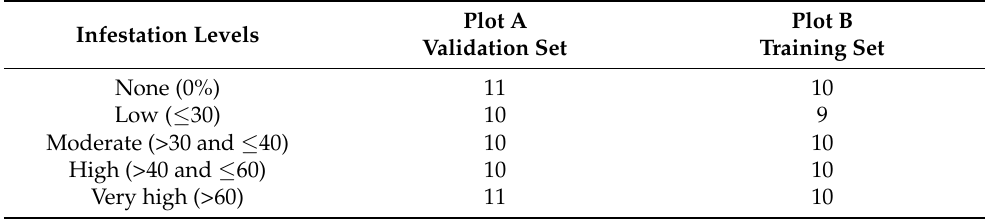
Table 3. Description of the datasets distinguishing by plot and purpose (training and validation). 147 Plot A Plot A Plot B Infestation Levels Validation Set Training